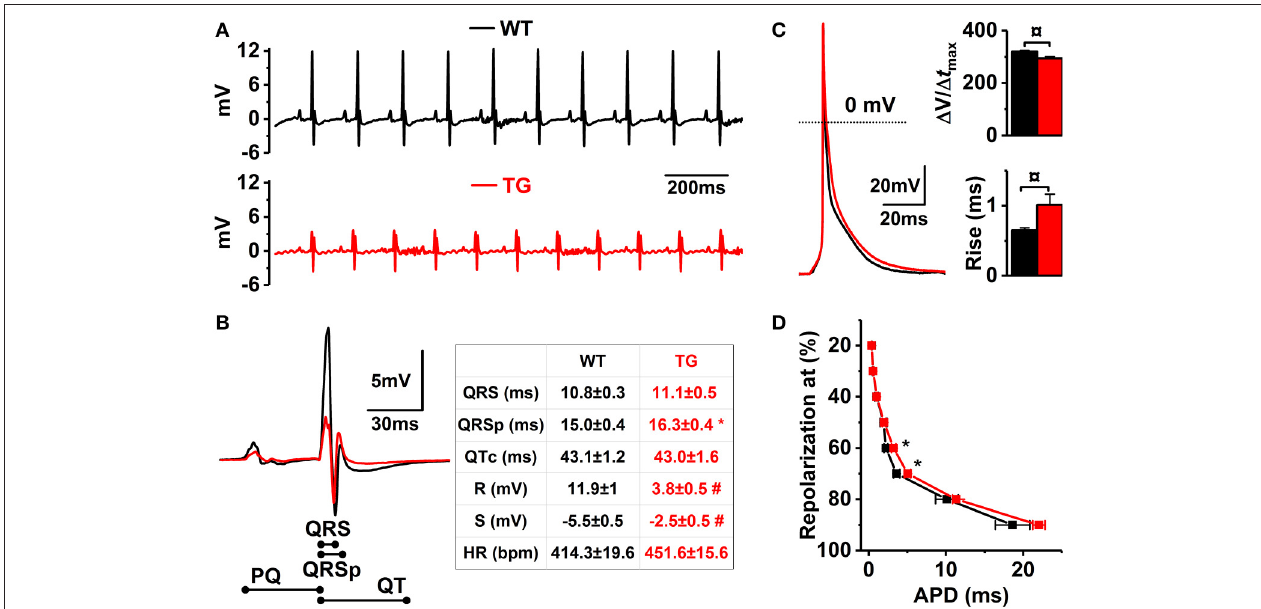
FIGURE 4 | Electrophysiological properties of VEGF-B TG hearts and isolated cardiomyocytes. (A) Representative ECG recordings from WT (black line) and VEGF-B TG (red line) mice. (B) Enlarged superimposed ECG complexes (left panel) with summary of the ECG parameters (right panel, n = 10 for both groups). (C) Representative superimposed AP traces from isolated myocytes (left) and means of the AP maximum rise slope (upper right) and rise time (lower right). (D) AP durations at different percentages of repolarization (WT n = 17 and TG n = 34; 4 animals for both group). * P < 0.05, ¤ P < 0.01 and # P < 0.001.